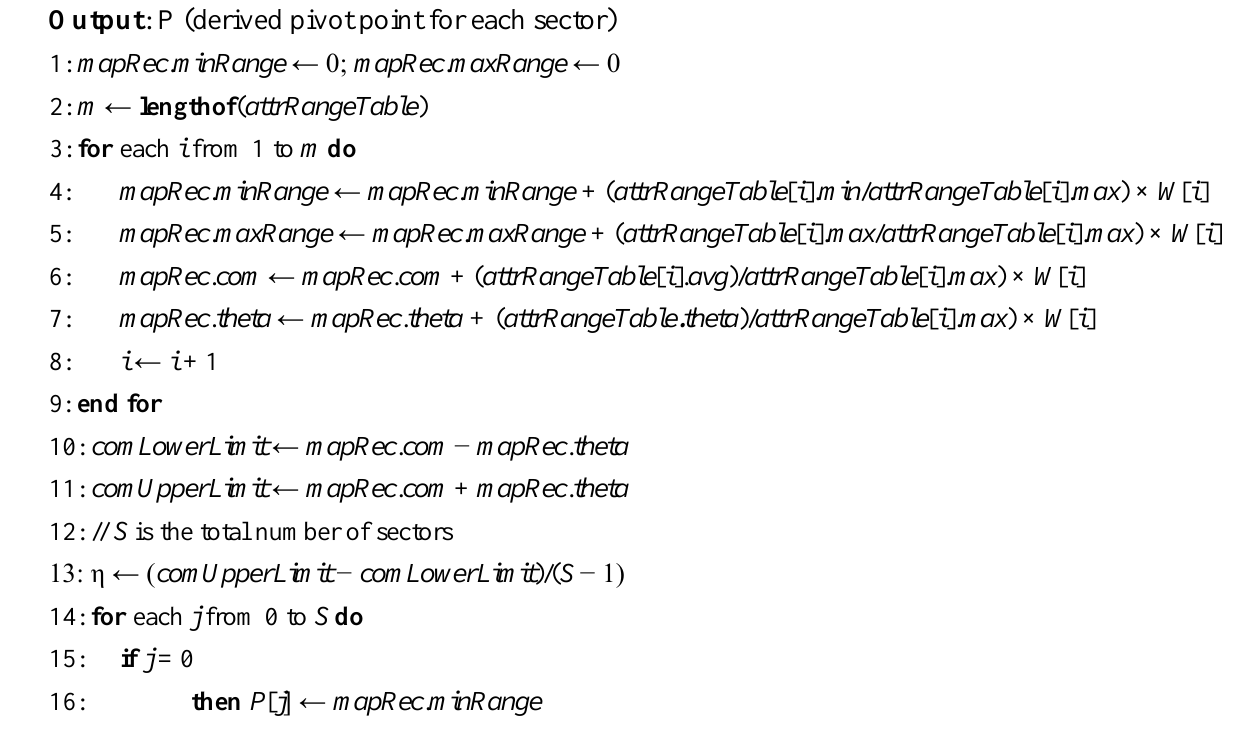
Algorithm 1. Pivot Point Generation Algorithm (implemented at each SH